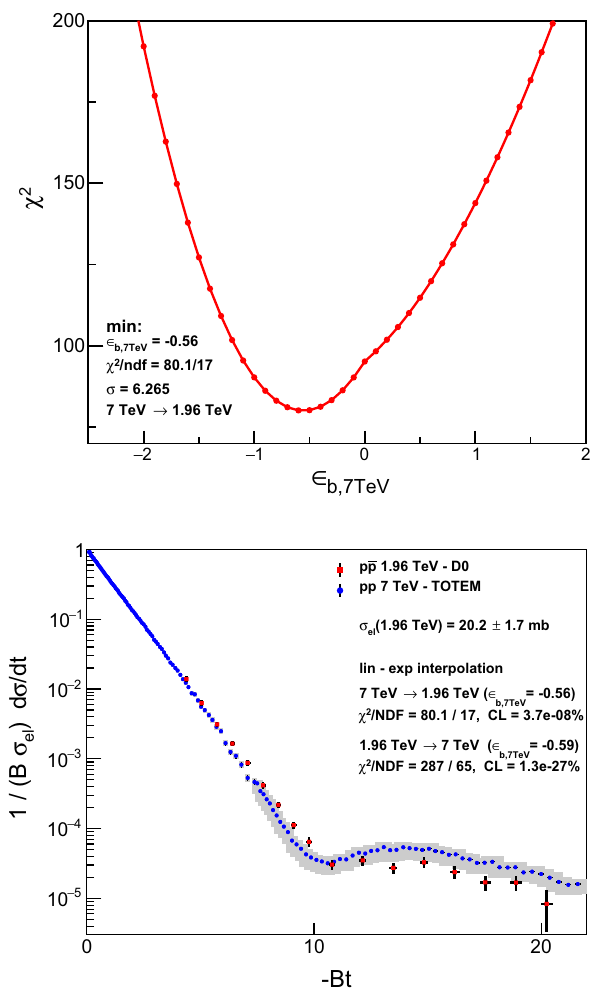
Fig. 15 Toppanelindicatesthatasafunctionof (cid:13) b , 7 TeV ,the χ 2 ≡ ˜ χ 2 distribution has a unique nearly quadratic minimum. The minimum valueis χ 2 / NDF = 80 . 1 / 17,correspondingtoastatisticallysignificant difference between the pp and p ¯ p H ( x ) scaling functions at the level of 6 . 26 σ . The bottom panel shows the comparison of the H ( x ) data using the values of (cid:13) b , 7 TeV corresponding to such a minimum, both for the case of the 7 → 1 . 96 TeV and for the case of 1 . 96 → 7 TeV projections